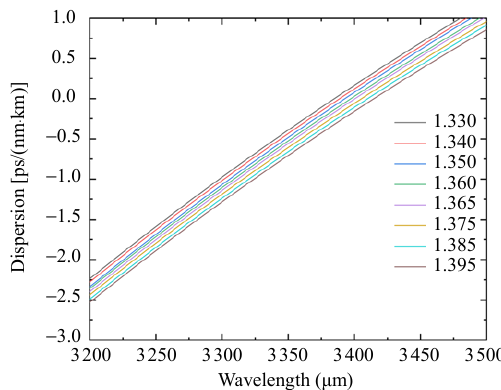
Fig. 2 Dispersion of the TPCF filled with liquids of different refractive